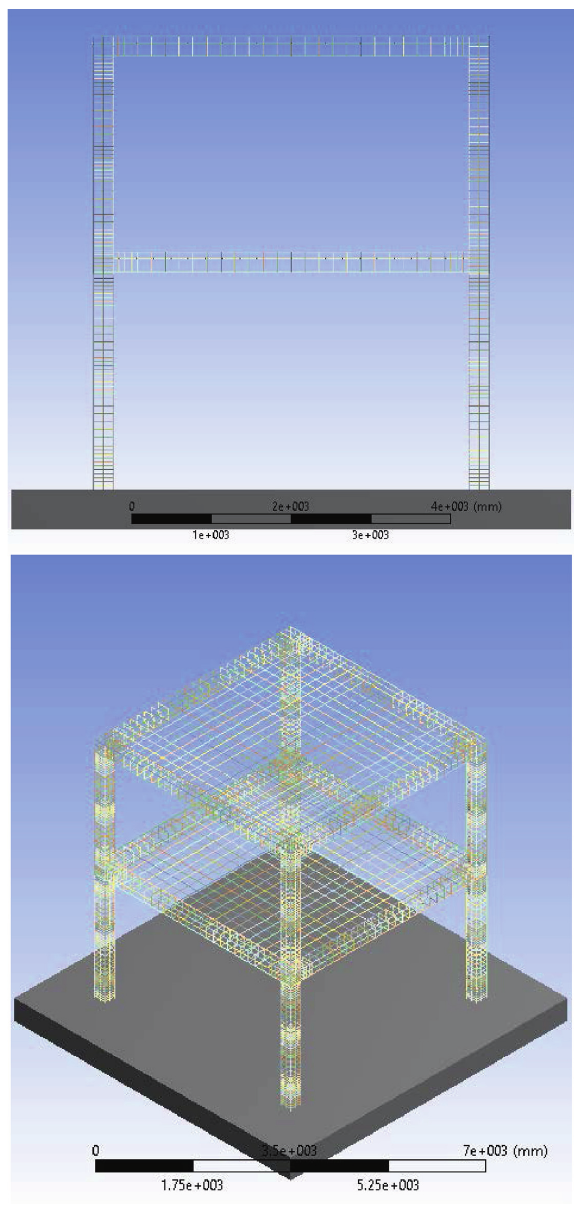
Figure 15: Reinforcement detailing for FRM_REI_DET_#3 on AUTODYN.